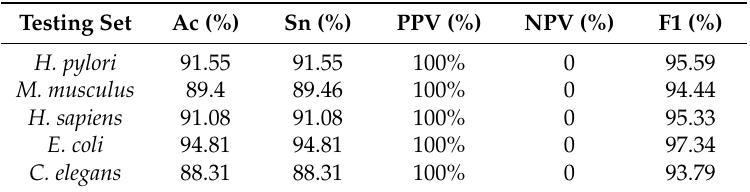
Table 4. Prediction performance on five species based on our model. PPV: Positive Predictive Value; NPV: Negative Predictive value; F1: F-Score. Testing